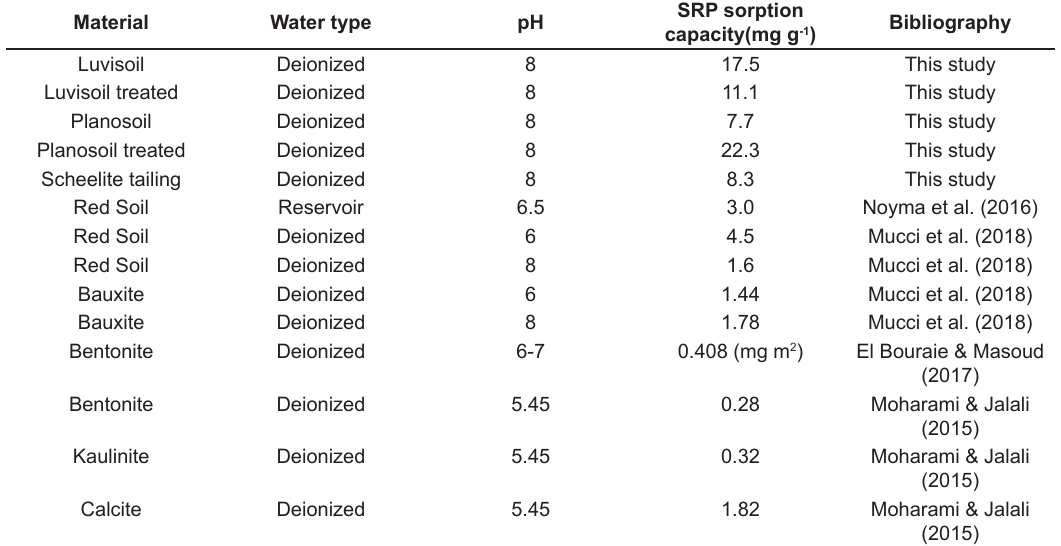
Table 4. Data gathered from the literature and the results of this study regarding the maximum SRP adsorption capacity of natural soils in deionized and natural water under different pH